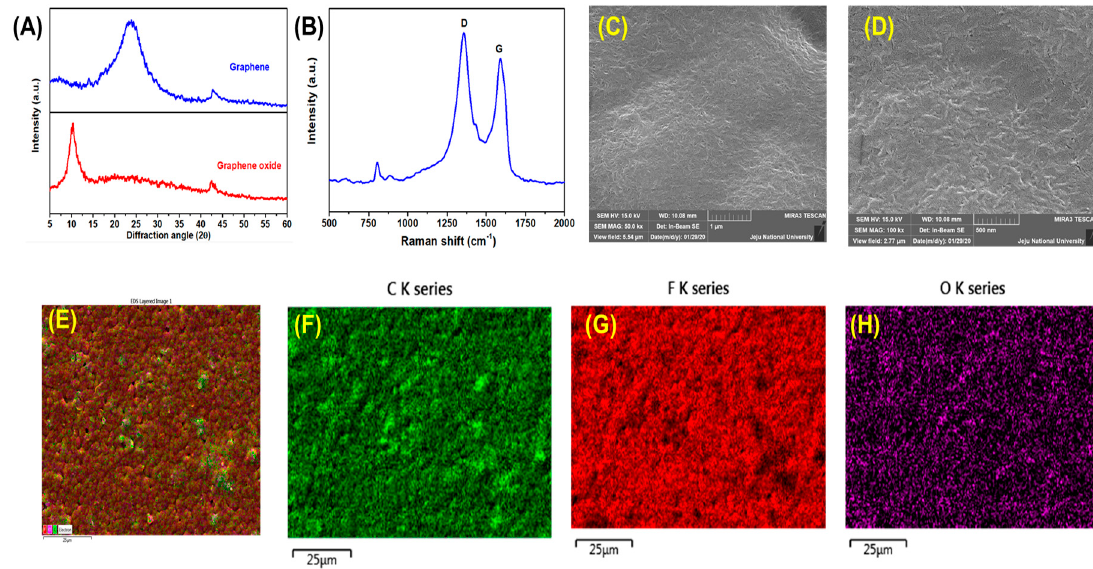
Figure 3. ( A ) X-ray diffraction pattern of the graphene and graphene oxide. ( B ) Laser Raman spectrum of the PVDF/reduced graphene oxide composite film. Surface morphology of the PVDF/reduced graphene oxide composite film, ( C ) low resolution, and ( D ) high-resolution micrographs. Elemental mapping analysis of the PVDF/reduced graphene oxide composite film ( E ) overlay field-emission scanning electron micrograph of PVDF/reduced graphene oxide composite film, ( F ) elemental mapping showing the distribution of C element, ( G ) elemental mapping showing the distribution of F element, ( H ) elemental mapping showing the distribution of O element present in PVDF/reduced graphene oxide composite film.